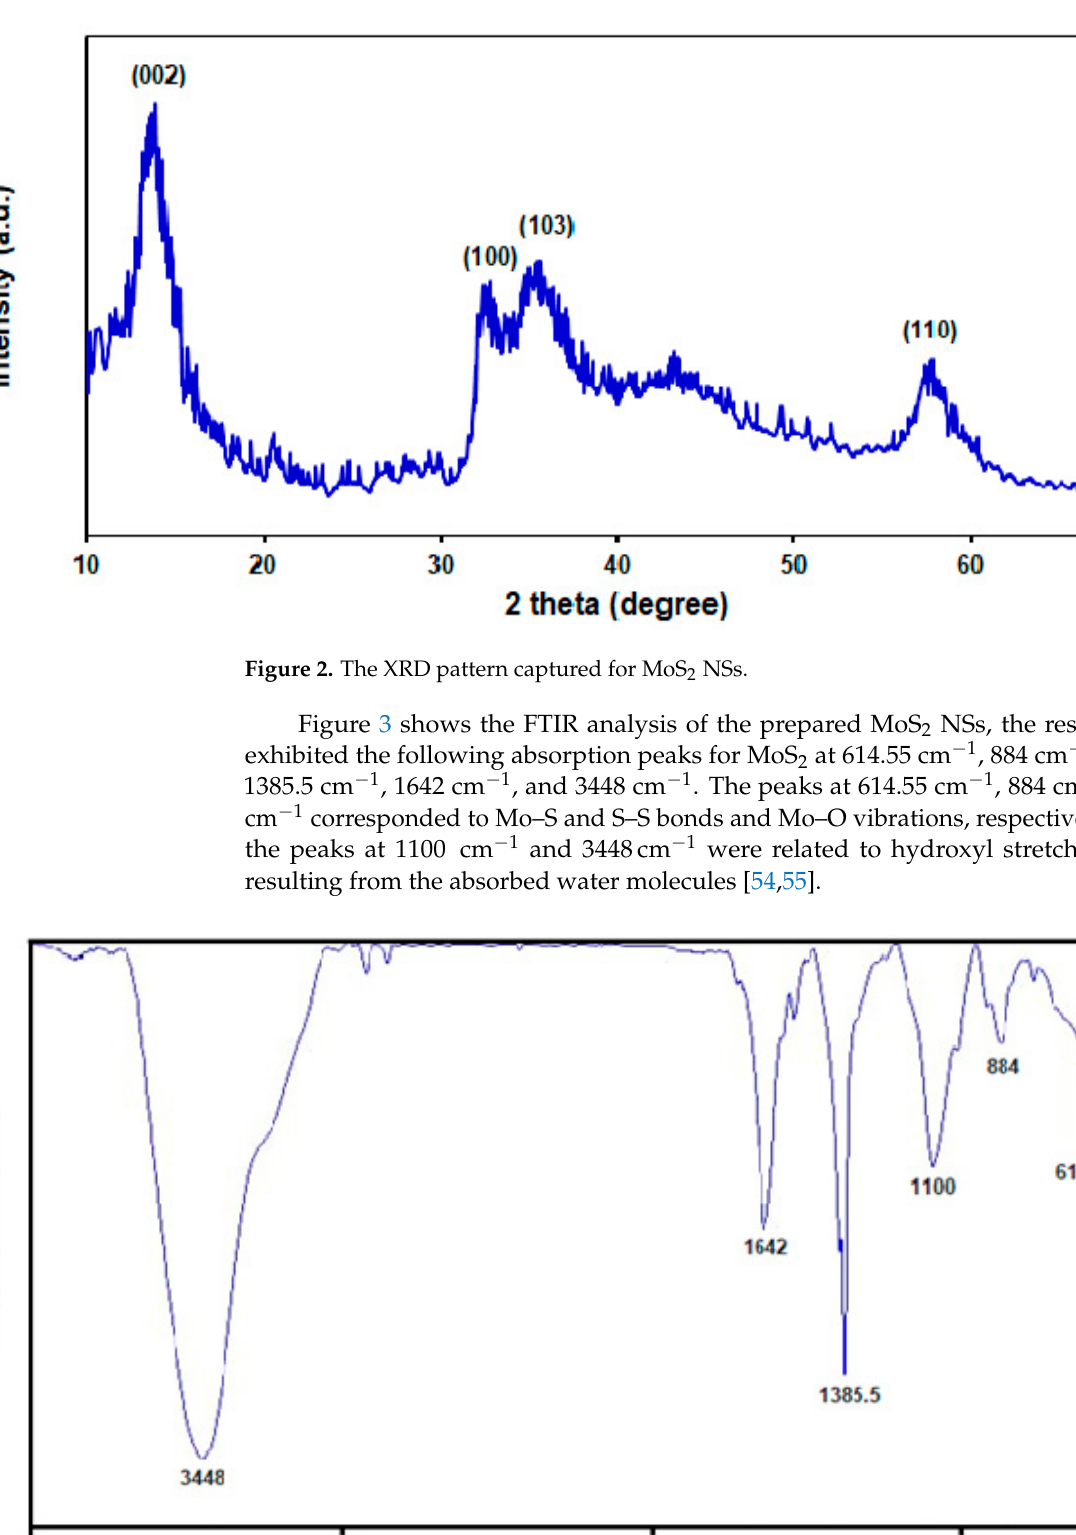
Figure 3. The FTIR spectrum captured for MoS 2 NSs.